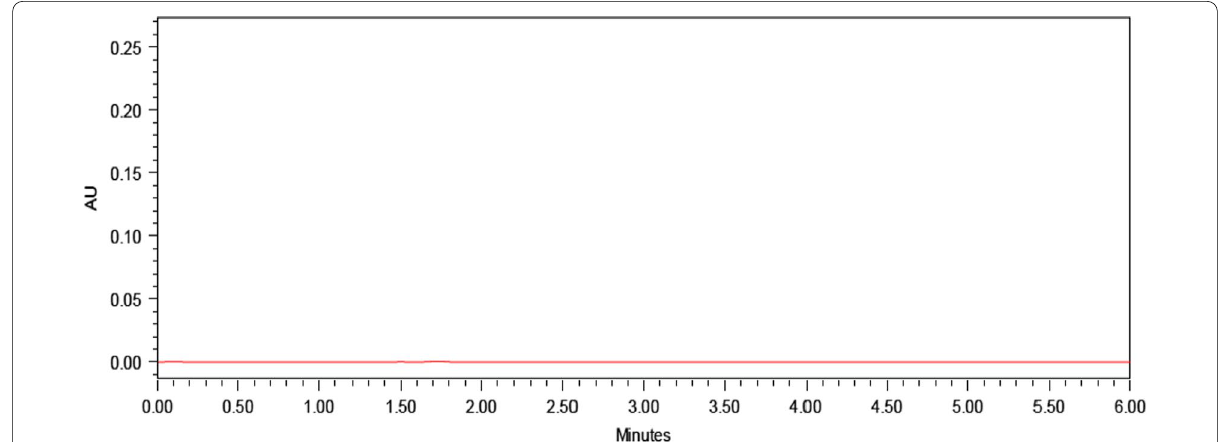
Fig. 3 Blank chromatogram of UPLC